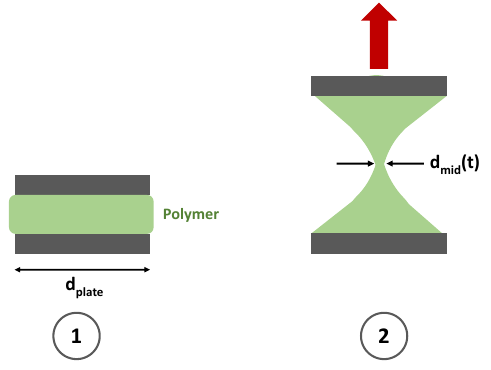
Figure 9. Measurement process of a CaBER ™ rheometer. ( 1 ) Introducing the polymer between plates to form a fluid bridge, ( 2 ) Rapid movement of the upper plate to create filament.